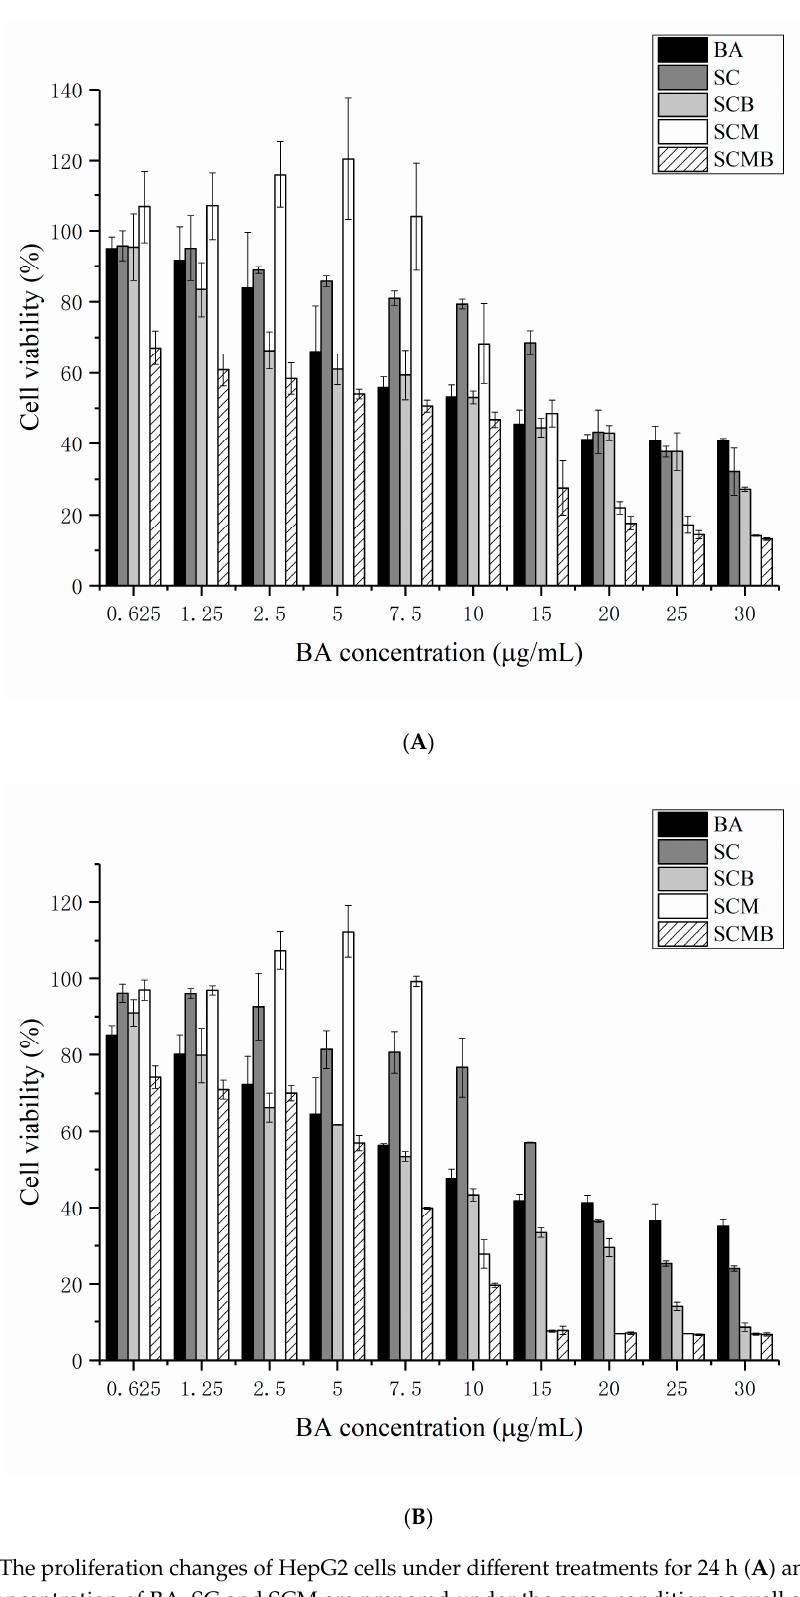
Figure 6. The proliferation changes of HepG2 cells under di ff erent treatments for 24 h ( A ) and 48 h ( B ). At each concentration of BA, SC and SCM are prepared under the same condition as well as SCB and SCMB whether adding BA or